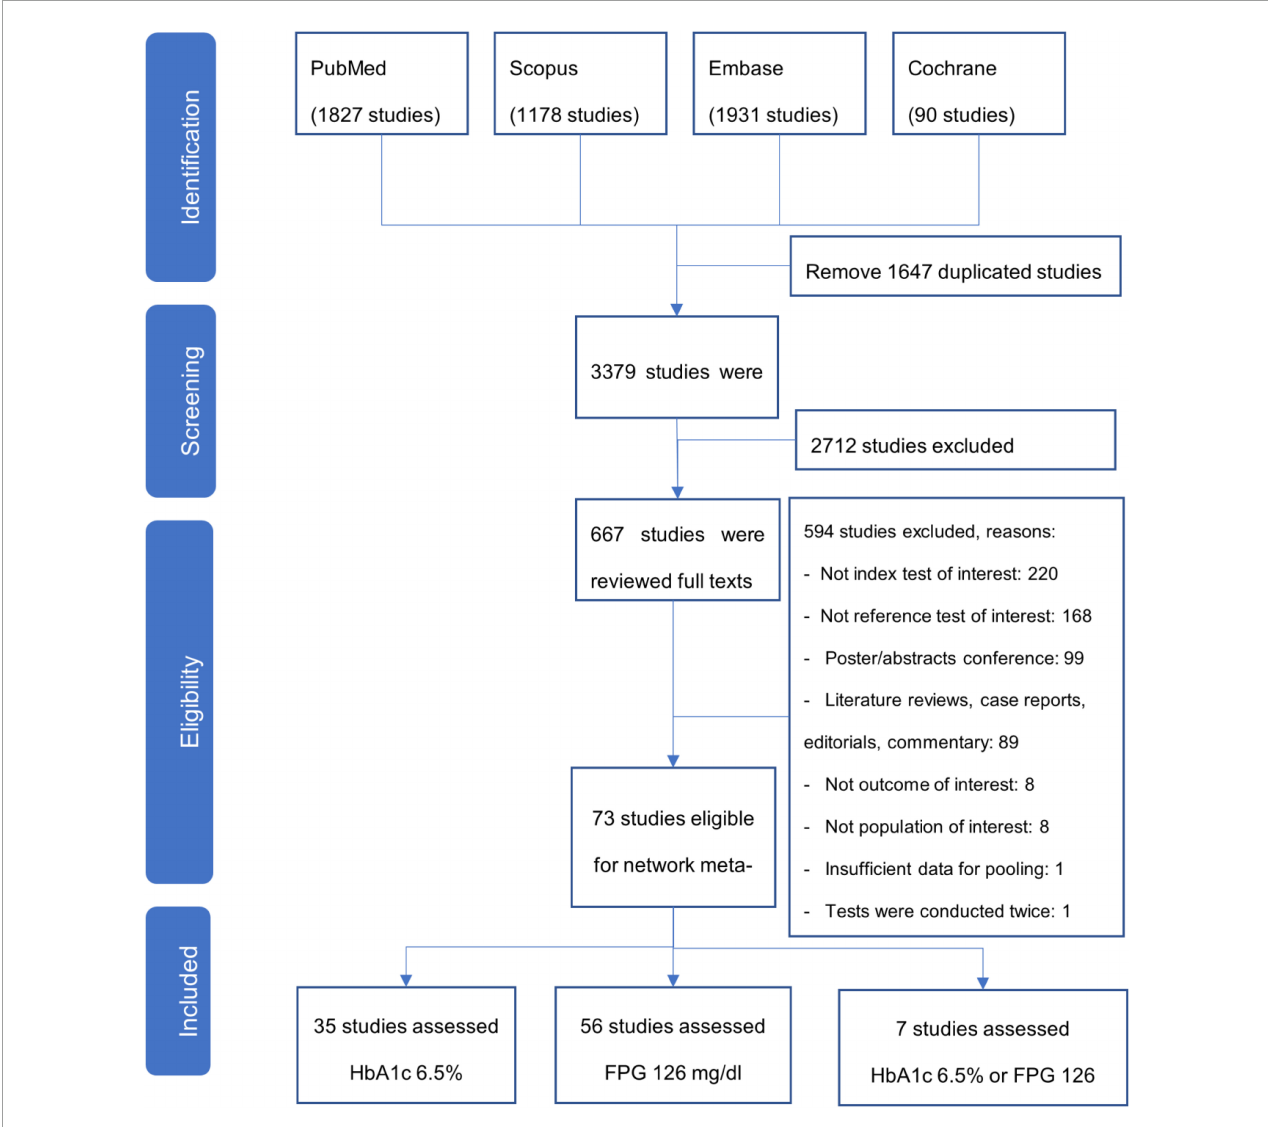
FIGURE1 PRISMA flow chart of study